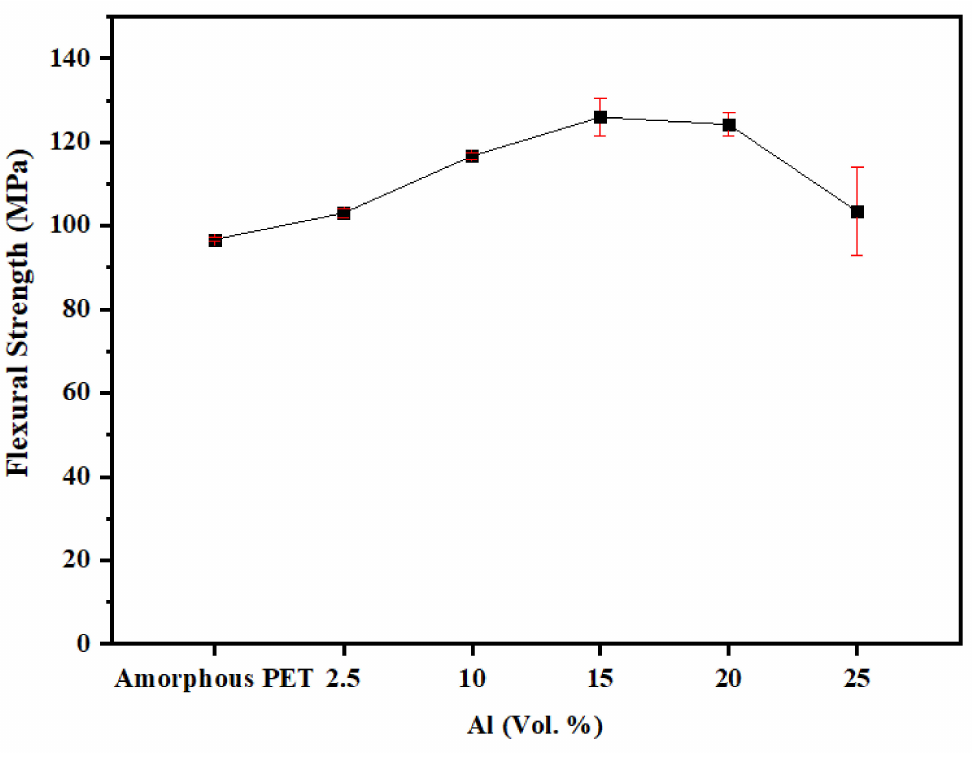
Figure 11. Flexural strength of amorphous PET filled with Al nano